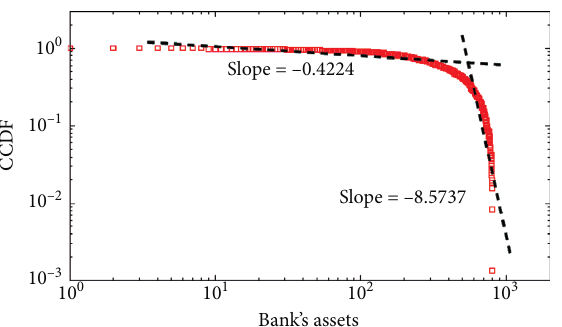
Figure 4: A log-log complementary cumulative distribution function (CCDF) of the assets (weight), according to simulation of our modeling using the network configuration of N ( 768 , 100 , 2 , 5 )